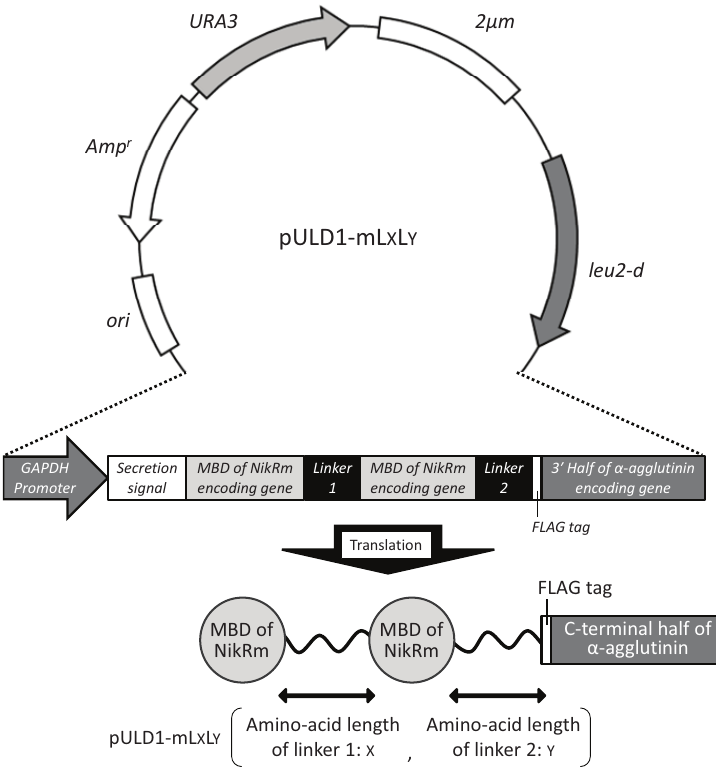
Figure 1. Plasmid pULD1-mL X L Y constructed for displaying tandemly fused metal-binding domains (MBDs) of NikR mutant (NikRm) on the yeast cell